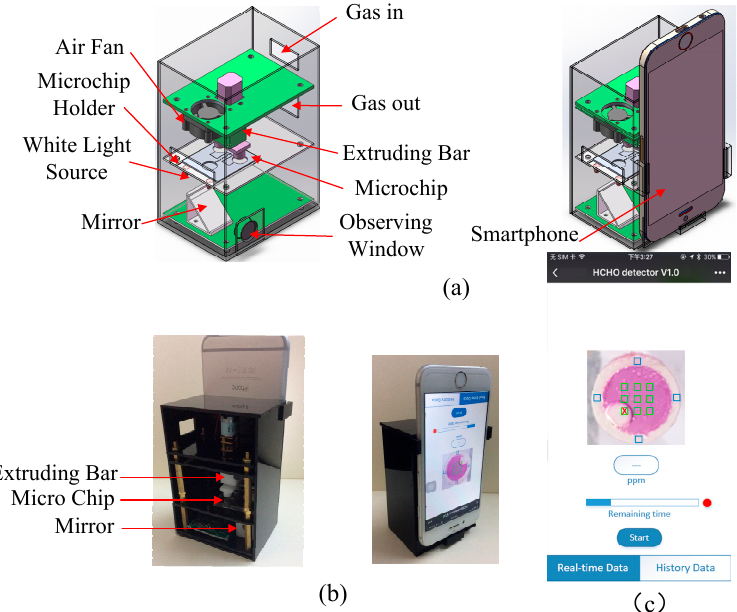
Figure 2. ( a ) The diagram of the smartphone-based formaldehyde determination system. ( b ) The photographs of the smartphone-based formaldehyde determination system. ( c ) The user interface of the app.